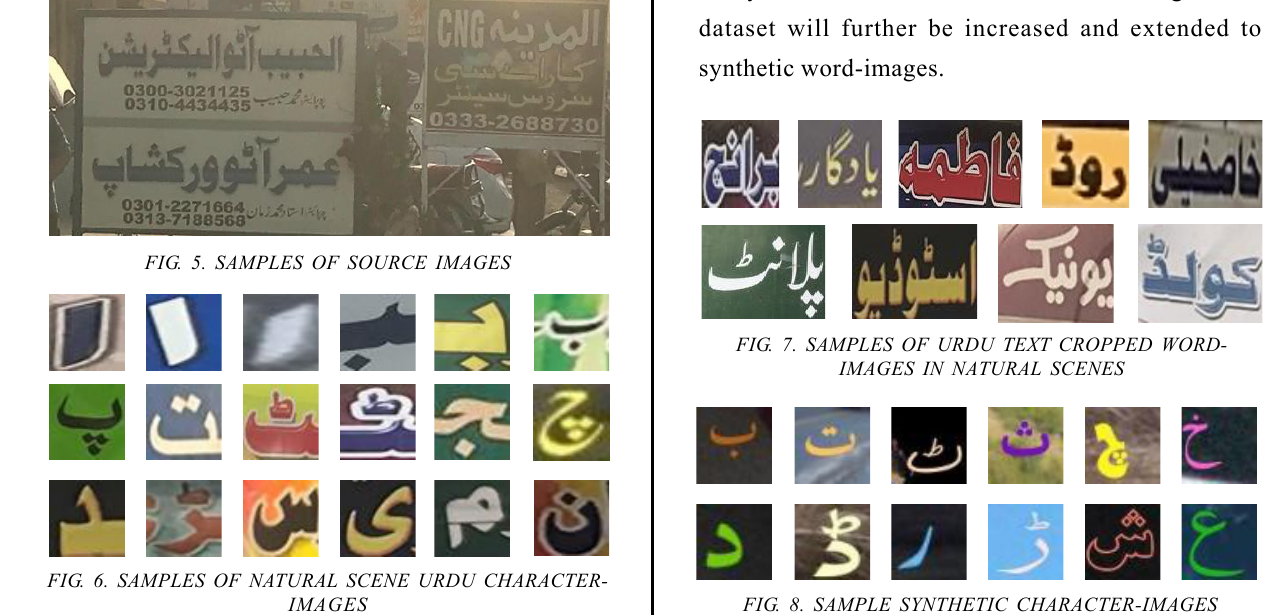
FIG. 6. SAMPLES OF NATURAL SCENE URDU CHARACTER- IMAGES